Question: Generate an informative caption for the figure above.
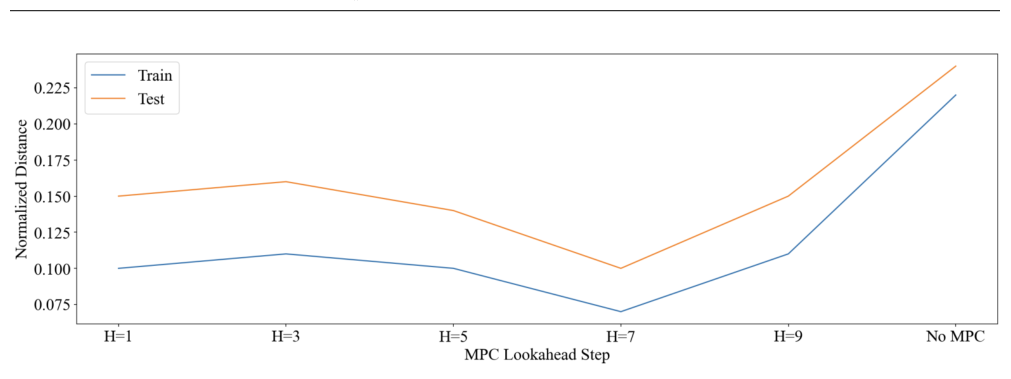
Answer: Ablation Studies on Lookahead Horizon. The plot shows the normalized distance performances of different H values on both train and testing objects.